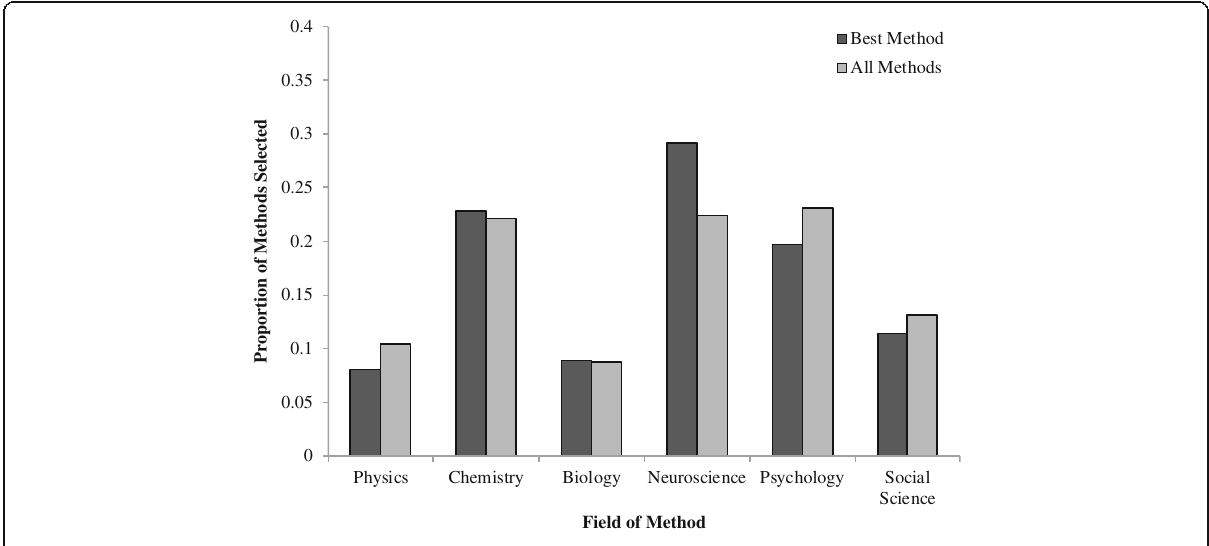
Fig. 3 Proportion of times each method was selected across all